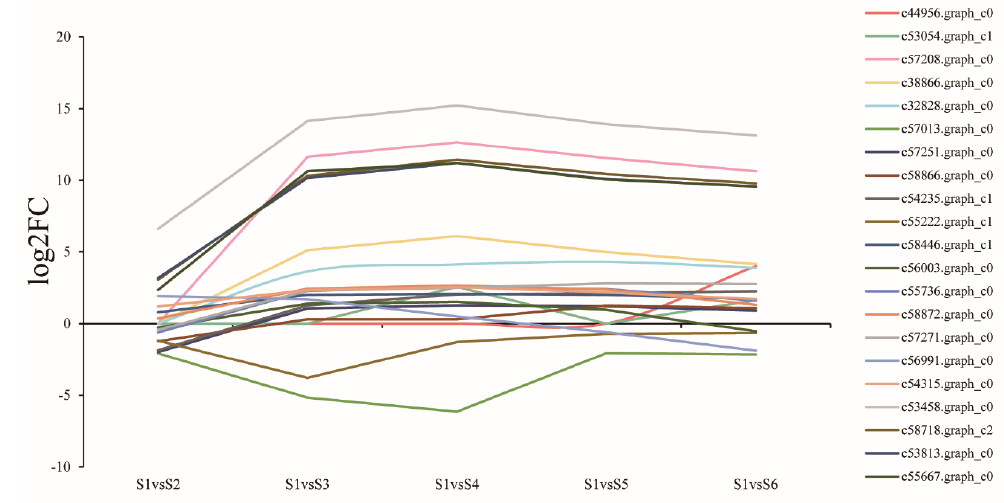
Figure 8. The log 2 of the fold change variations of the cellulose synthase genes at five time points.